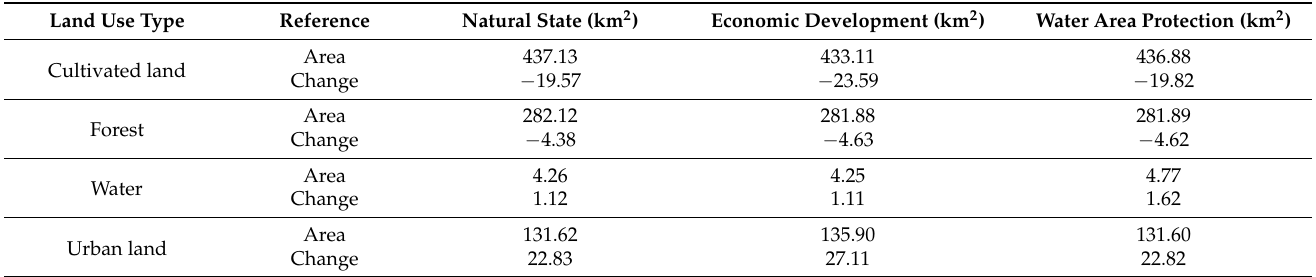
Figure 9. Prediction of land use in Qishan under three scenarios in 2030. “natural state” with the status quo unchanged, “economic development state” with accelerated expansion of urban land, and “water conservation state” without water output. Table 6. Prediction of land use change in Qishan under different scenarios from 2020 to 2030.